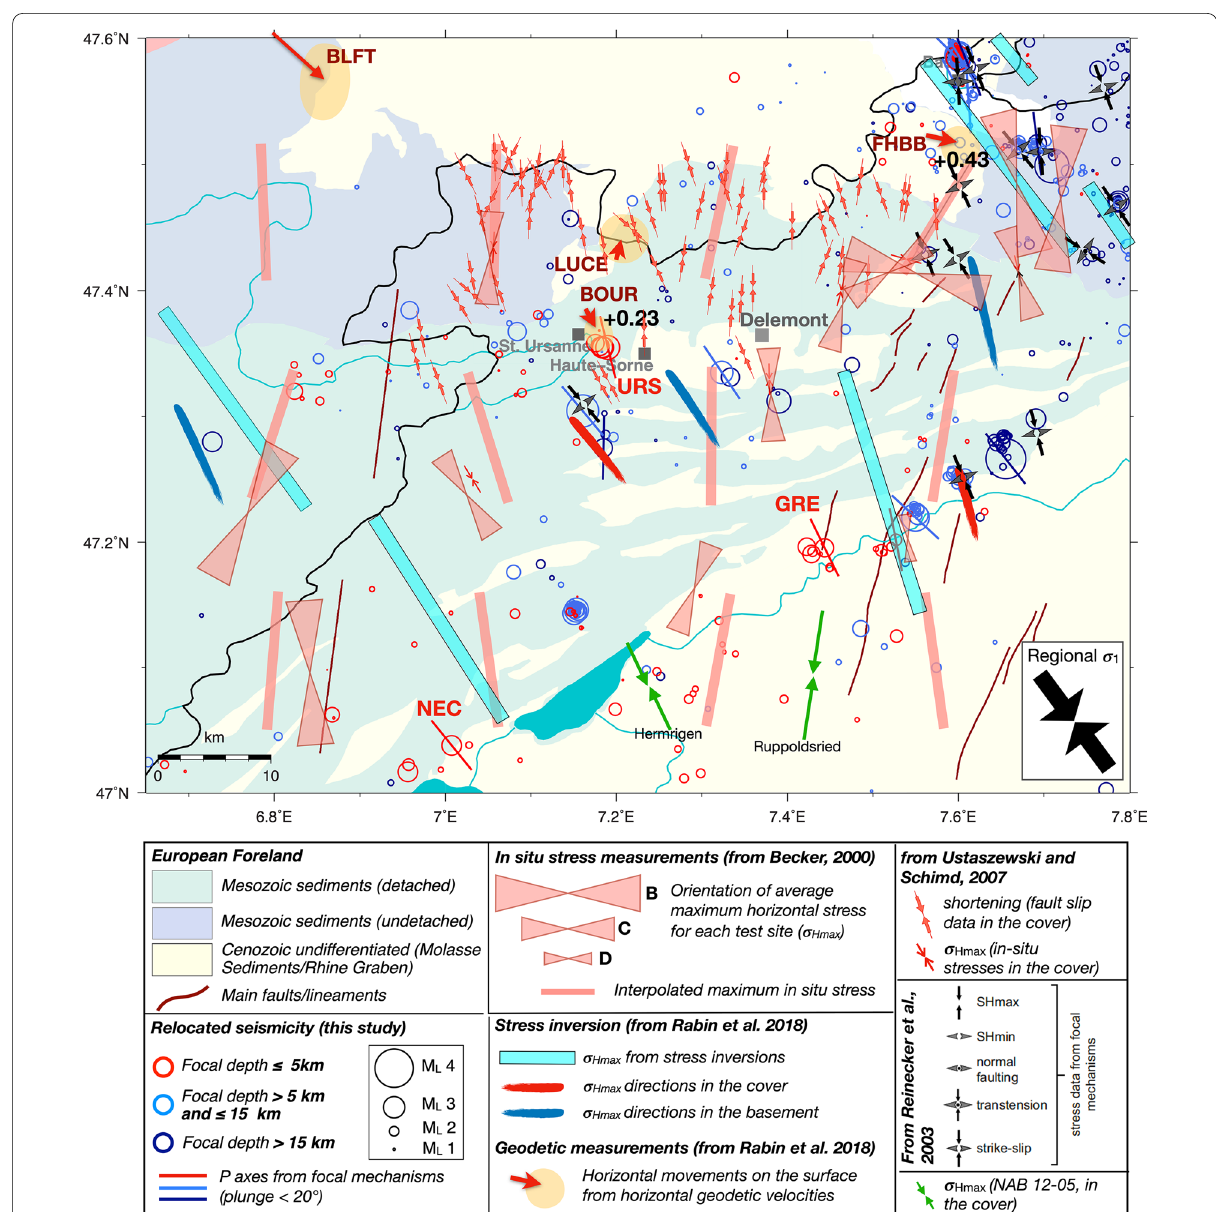
Fig. 13 Summary of in-situ stress measurements from Becker (2000), stress inversion from Rabin et al. (2018), paleostress fault-slip data (post 2.9 Ma) from Ustaszewski and Schmid (2006), stress data from the 2003 release of the World Stress Map project (Reinecker et al., 2003), data from Nagra drill sites Hermrigen and Ruppoldsried (Heidbach & Reinecker, 2013), and P-axes derived in this study. Please refer to the legend for symbols explanations. Note that σ Hmax -orientations regarding recent near-surface deformation (in situ measurements, red butterfly symbols) tend to scatter between NNW and NNE, paralleling the shortening directions determined from the fault-slip data (white arrows). σ Hmax -orientations obtained from seismic activity within the Paleozoic crystalline basement (black arrows), however, are predominantly and more systematically